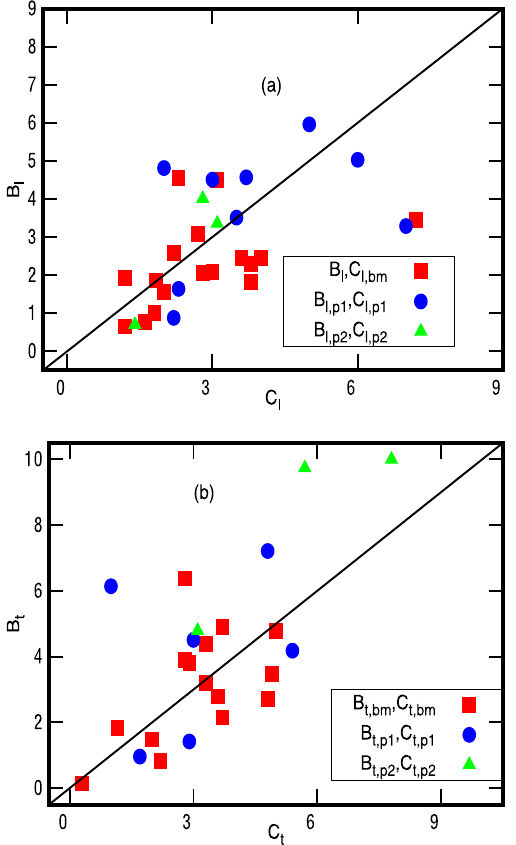
Figure 4. Comparison of B a - values ( a = l , t ), for 18 glasses from Eq. (47), for M = M 1 , with their experimentally known tunneling strengths : here the B a 1, xx -values correspond to y -coordinates of the points marked on the figure and C a , xx to their x -coordinates; the details of the labels are same as in Fig. 2. Here the solid line is shown only for visual